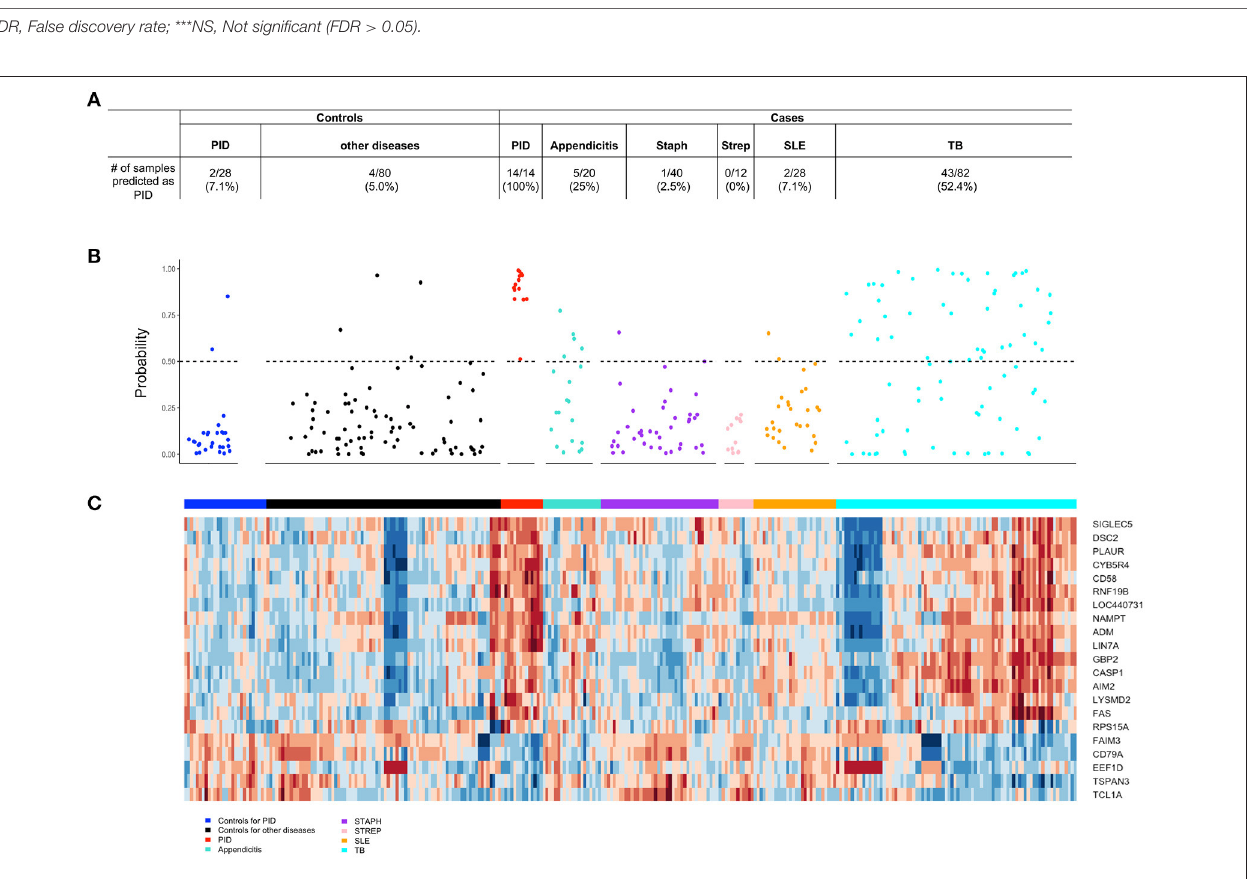
FIGURE 7 | The 21-gene biomarker distinguishes STI-induced endometritis from other infectious and inflammatory conditions. (A) The number of samples within each disease and control group predicted as STI-induced endometritis is summarized in the table. (B) The predicted probability of STI-induced endometritis in each disease and control group using a 21-gene biomarker. Each dot represents one subject. The x-axis indicates the groups of subjects and y-axis indicates the predicted probability of STI-induced endometritis. The dotted line corresponds to a predicted probability cutoff of 0.5. (C) Unsupervised hierarchical clustering using 21-genes revealed distinctive blood mRNA transcriptional profiles separating STI-induced endometritis from other diseases and controls. Study groupings (clinical phenotypes) are the colored blocks on the top of each profile. Heat map rows are genes; columns are participants. Transformed expression levels are indicated by color scale, with red representing relative high expression and blue relative low